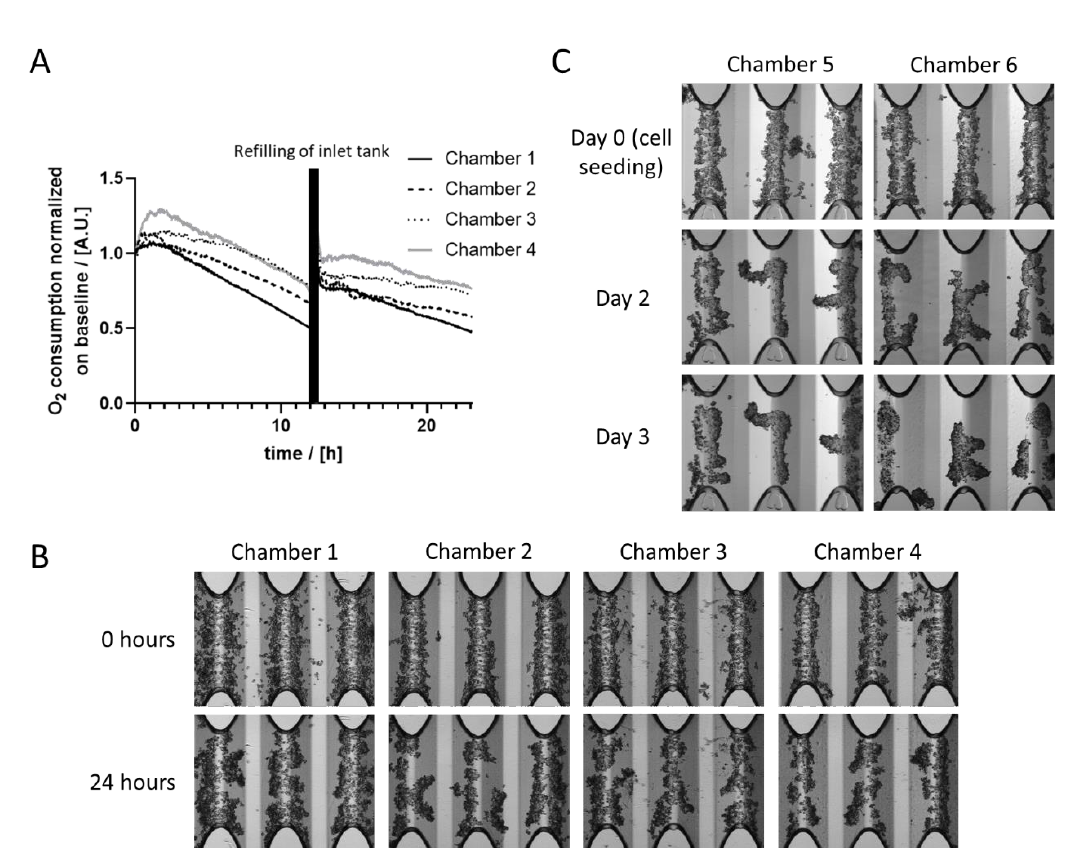
Figure 2: OC of PHH cultured in the HepaChip-MP. A ) In cell culture chambers containing microtissues, the OC drops over time. After re-adjusting the medium level difference between inlet and outlet after 12 hours, flow rate increases and the OC immediately rises to a higher level. B ) Microscopic images of the cell culture chambers analyzed in A ) at the start and the end of the measurement exhibit a slight decrease of cell number. C ) Representative images of cells cultured in the HepaChip-MP from the day of seeding (day 0) and day 2 and day 3 of culture. Oxygen measurements after substance treatment were carried out at day 2 and day 3 of the culture in this